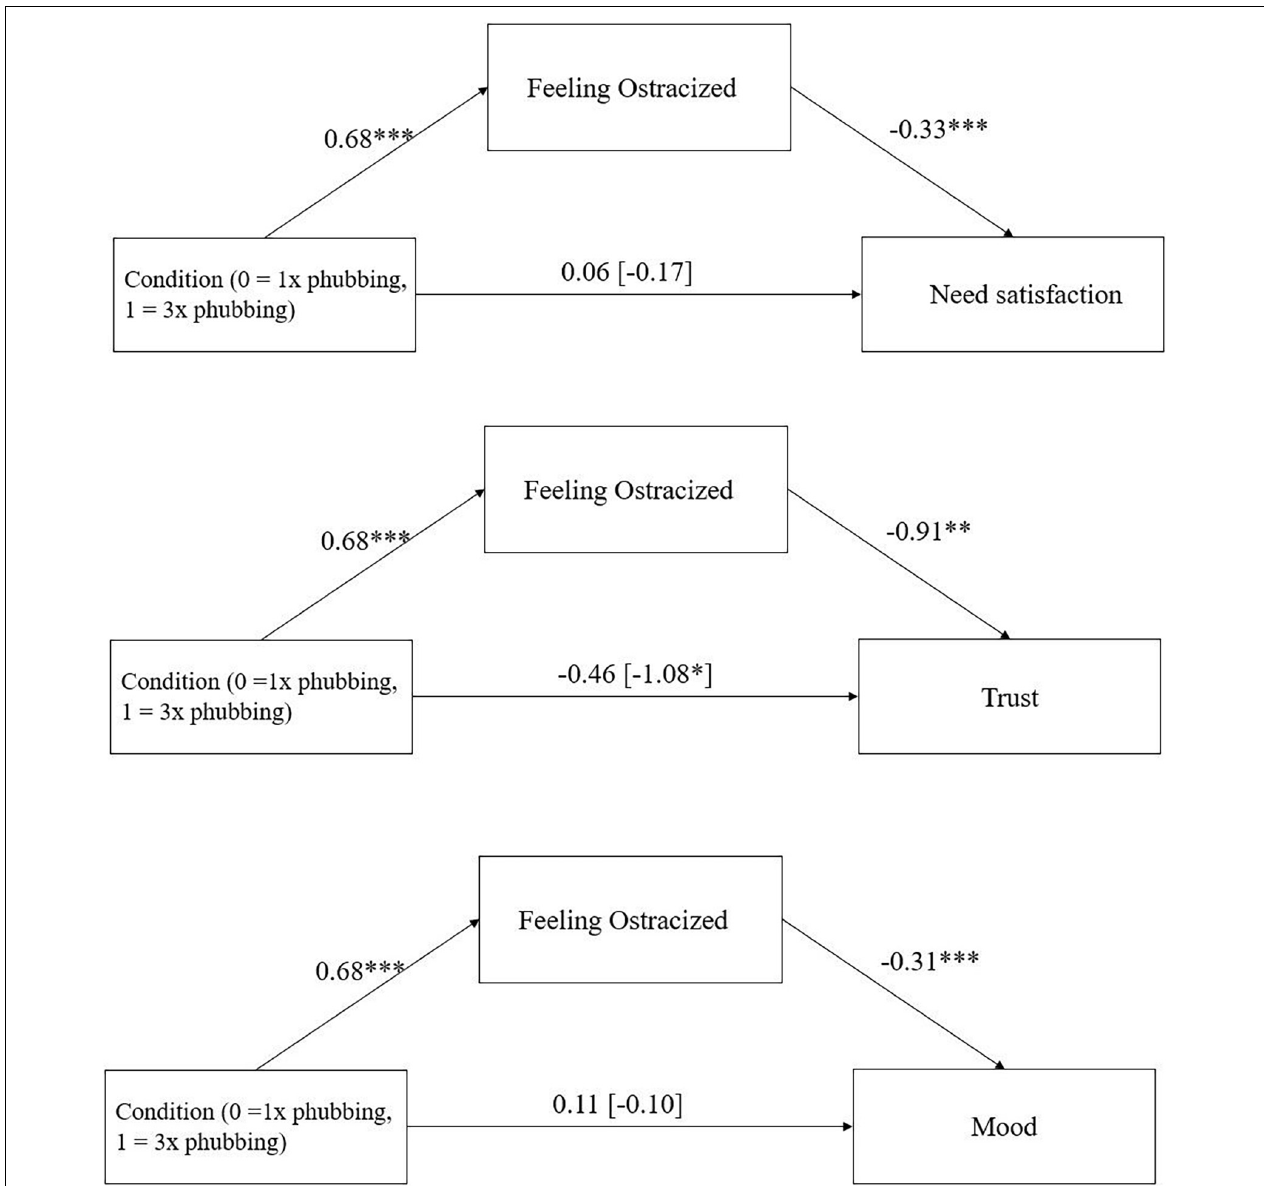
FIGURE 3 | Mediation effect of condition (1x phubbing vs. 3x phubbing) via feelings of ostracism on need satisfaction, trust in the trust game, and mood in Study 2 including the direct effect of condition on need satisfaction and mood (with total effect in parentheses). ∗ p < 0.05, ∗∗ p < 0.01, ∗∗∗ p <